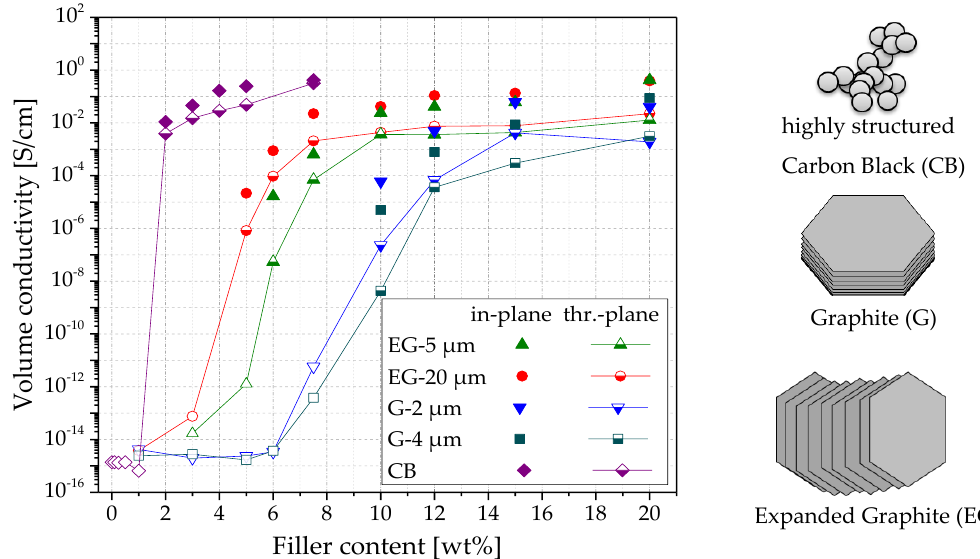
Figure 8. Volume conductivity vs. filler content for PVDF composites with carbon black (CB), expanded graphite (EG), and graphite (G), measured in two directions on compression molded plates. Open symbols measured using a Keithley 8009 measuring device.